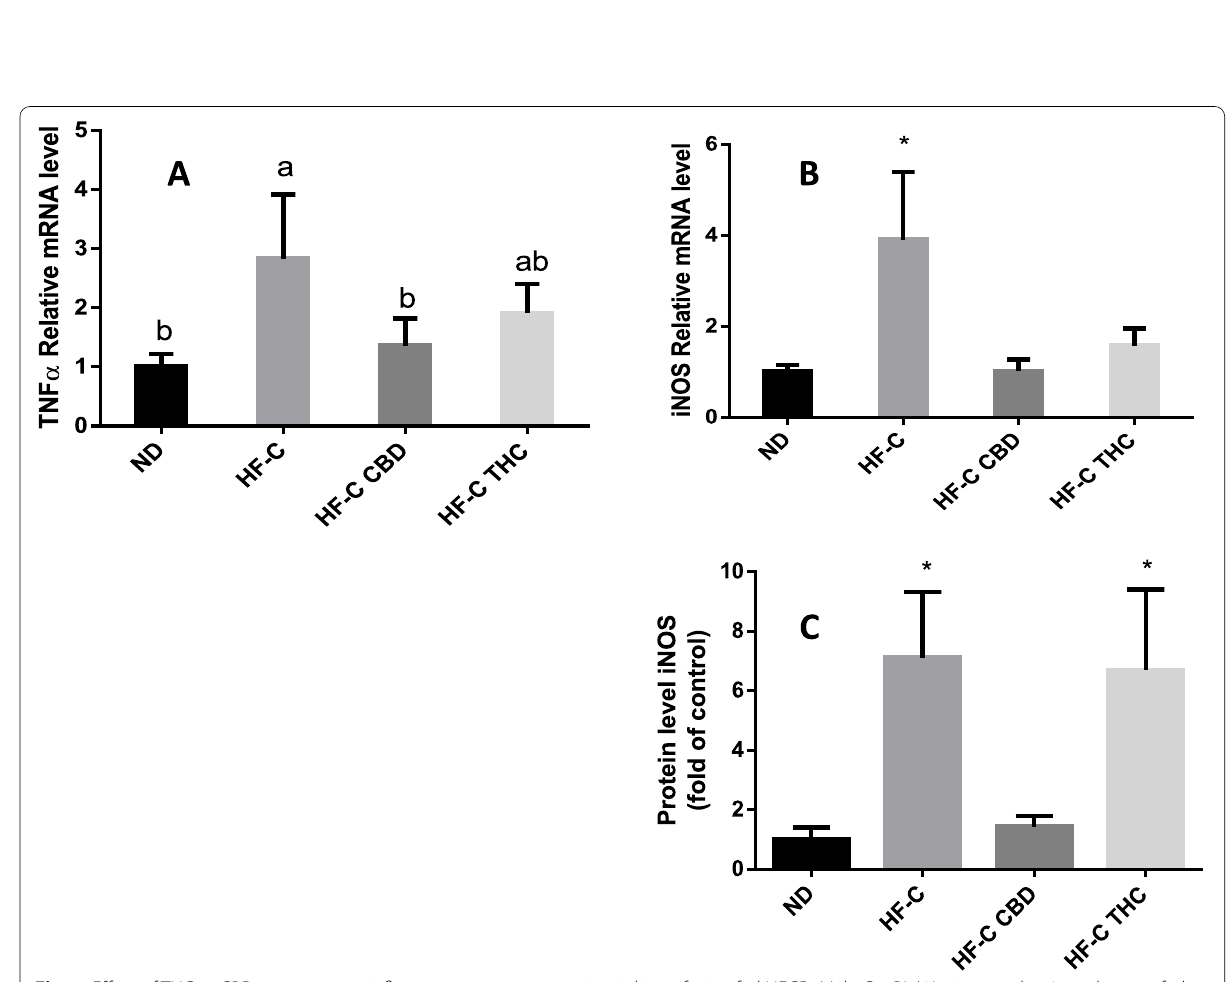
Fig. 7 Effect of THC or CBD treatment on inflammatory gene expression in liver of mice fed HFCD. Male C57BL/6J mice aged 7–8 weeks were fed either normal diet (ND, n 8), high fat 1%(w/w) cholesterol 0.5%(w/w) cholate diet (HF‑C, n 8), HFCD containing CBD (2.39 mg/kg) (HF‑C = + + = CBD, n 8), HFCD containing THC (2.5 mg/kg) (HF‑C THC, n 8). At the conclusion of the experiment, RNA was isolated from harvested livers and = = gene levels quantified using qPCR. Values are expressed as relative expression compared to ND (mean SEM). Values marked with different letters ± are significantly different ( p < 0.05) in the Tukey–Kramer test. iNOS, inducible nitric oxide synthase; TNFa, tumor necrosis factor